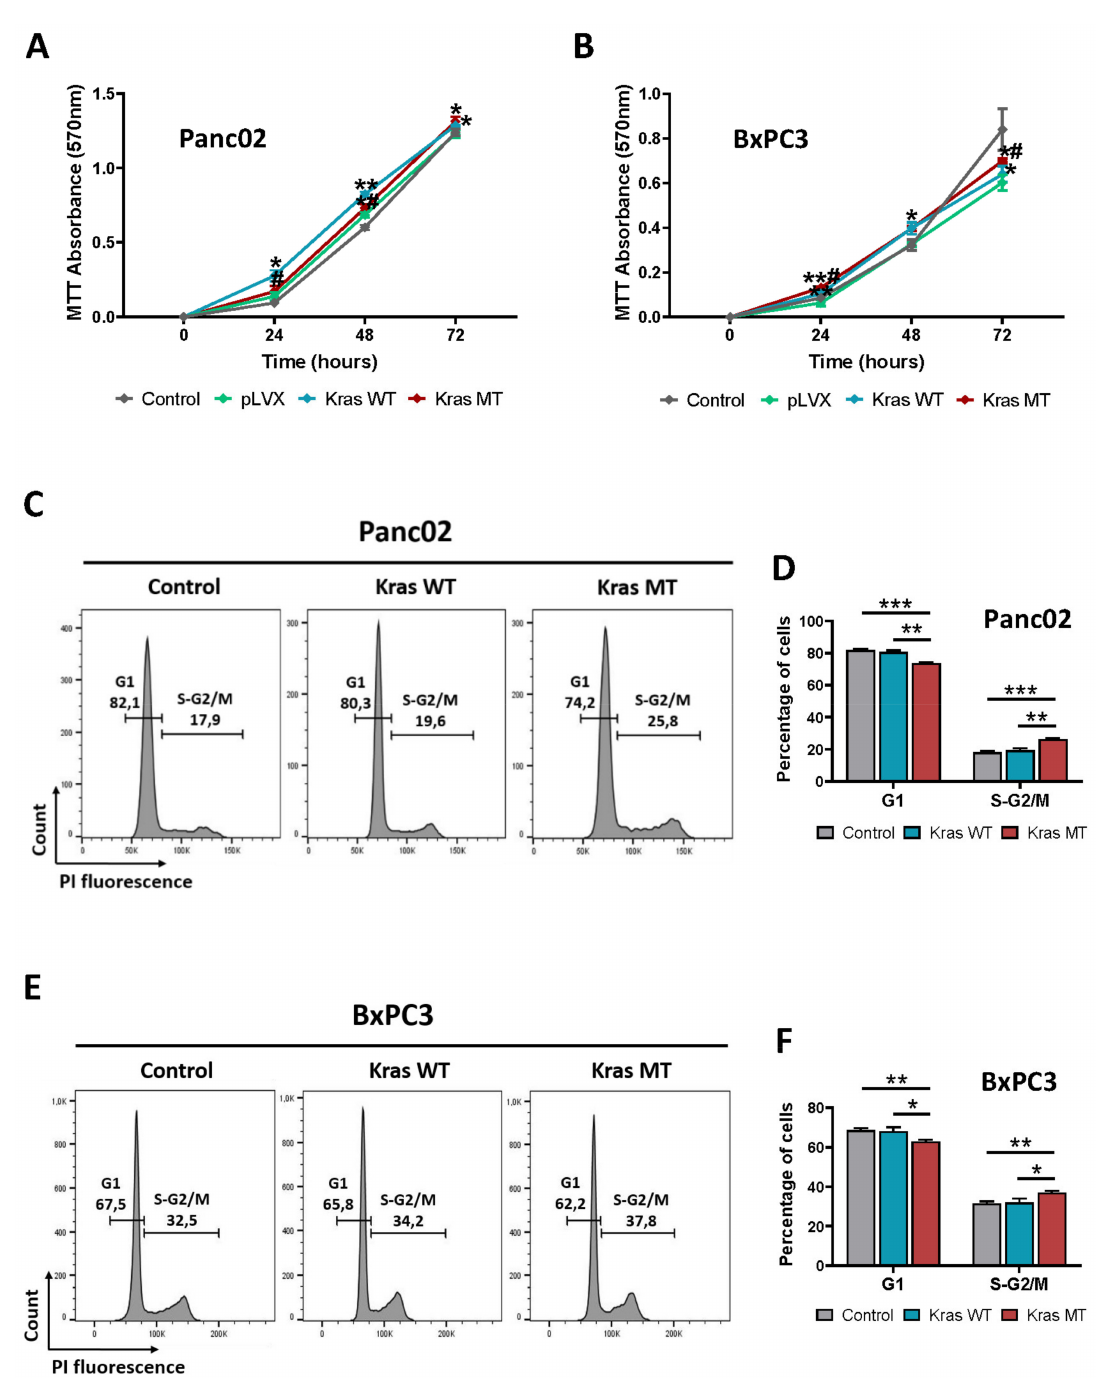
Figure 2. KRAS expression affects proliferation and alters cell cycle progression in pancreatic cancer cell lines. ( A , B ) The MTT assay was performed for 72 h and the absorbance of each well was read at 570nm. A representative proliferation graph of ( A ) Panc02 and ( B ) BxPC3 cells from three independent experiments is shown (mean ± SD; ** p < 0.01, * p < 0.05 compared to pLVX cells; # p < 0.05 compared to KrasWT cells; multiple t -test). ( C – F ) Cell cycle analysis of ( C ) Panc02 and ( E ) BxPC3 cell lines with respective quantification is presented. Viable cells were collected by trypsinization, and DNA content was analyzed after PI staining. Representative flow cytometry histograms of cell cycle analysis from three independent experiments are shown. Quantification of data from ( D ) Panc02 and ( F ) BxPC3 cells is presented. Error bars represent mean ± SD; * p < 0.05, ** p < 0.01, *** p < 0.001 (Student’s t